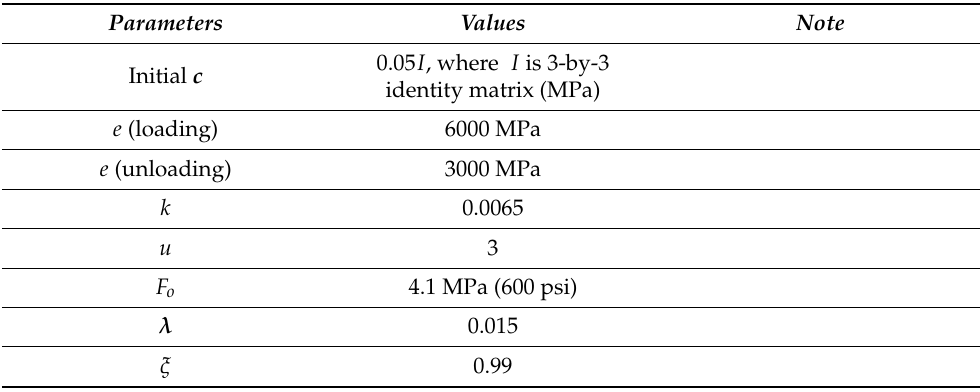
Table A5. Values of different parameters for sample 2 (test